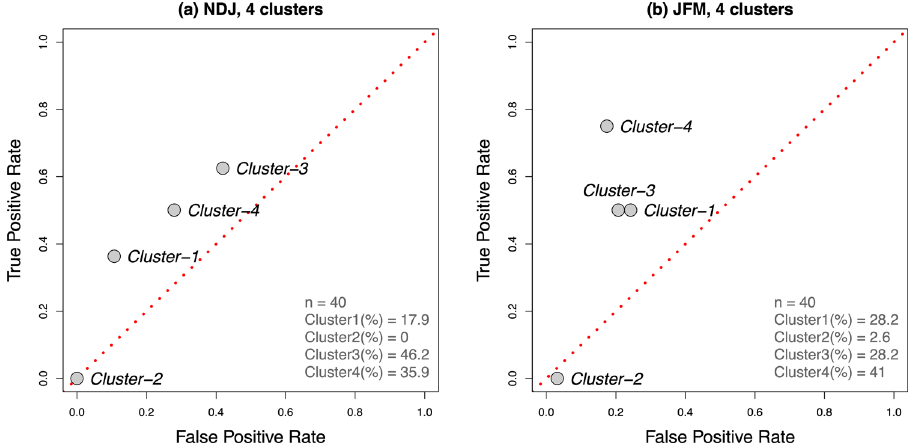
Fig. 4 ROC accuracy by cluster. ROC diagram for cluster predictions of NDJ season (panel a ) and JFM season (panel b ) from the Random Forest model on the test dataset (years 1980 – 2020). The percentage of predictions assigned to each cluster is given in the bottom right of each plot.